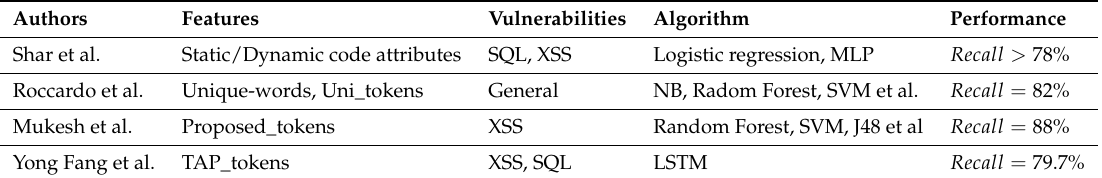
Table 1. Methodology and assessment indicators for other